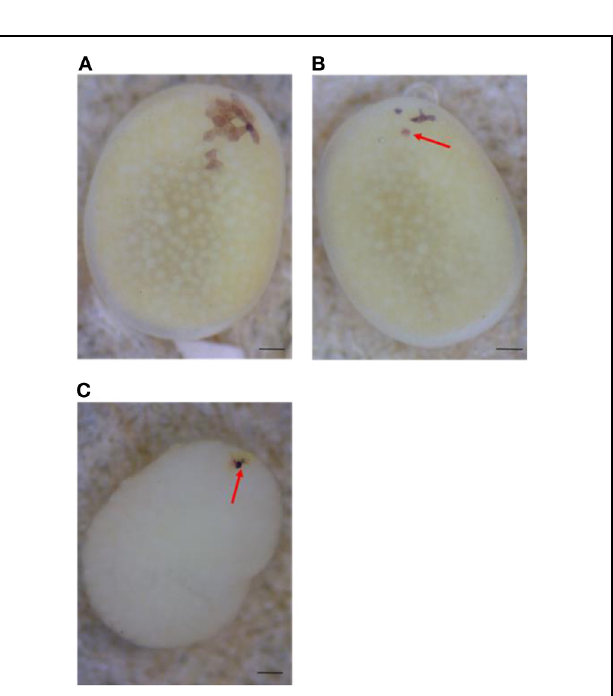
FIGURE 3 | Plausible model for the appearance of mosaic eggs. In the white eggs laid by a pe / + pe female crossed with a pe / pe male, the genotype of the fertilized nucleus is homozygous for pe . Meiosis proposed in this model was based on the pre-reduction model. (A) Most white cells come